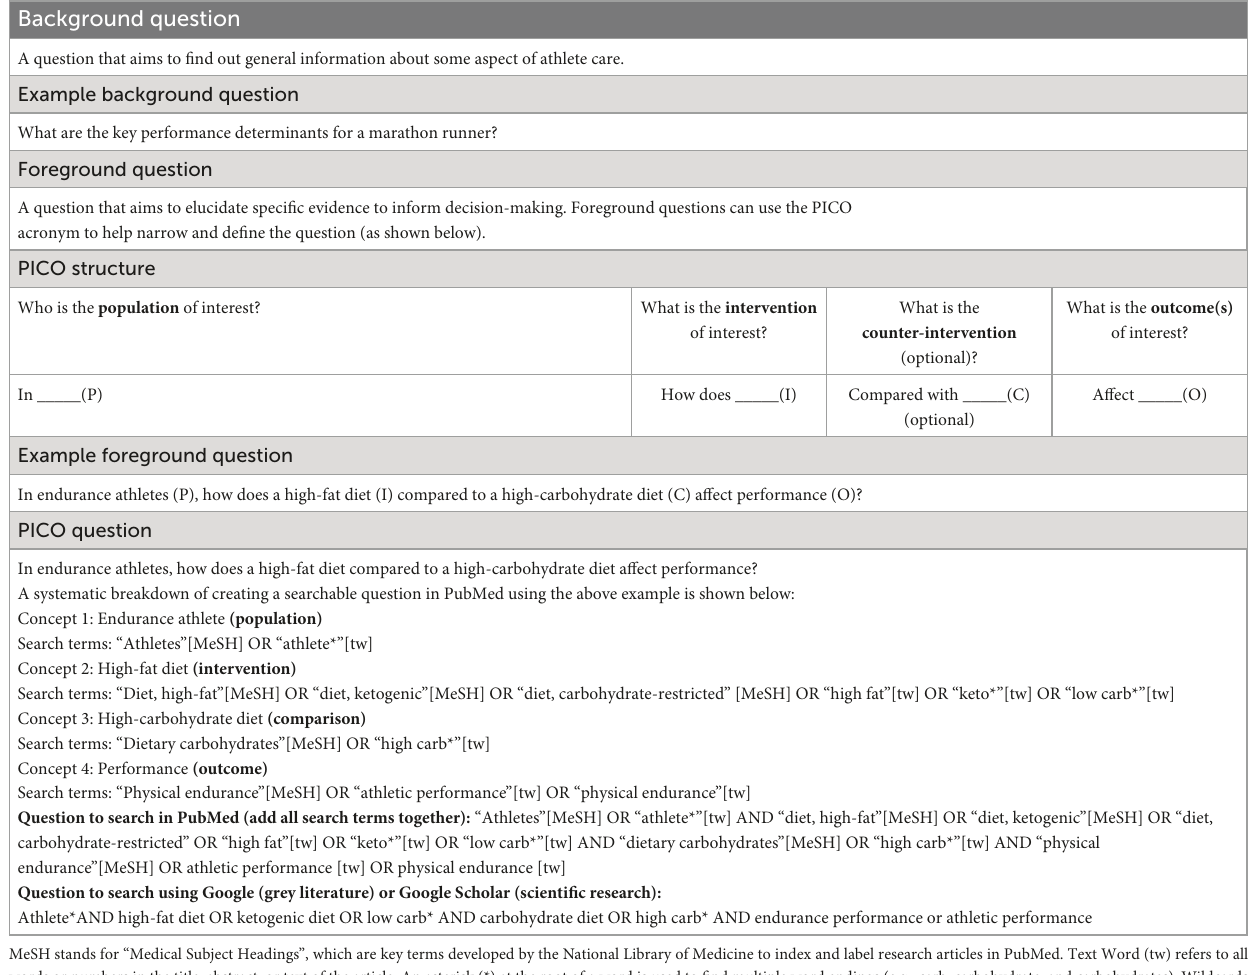
TABLE 1 An example of creating a foreground question using the PICO model in